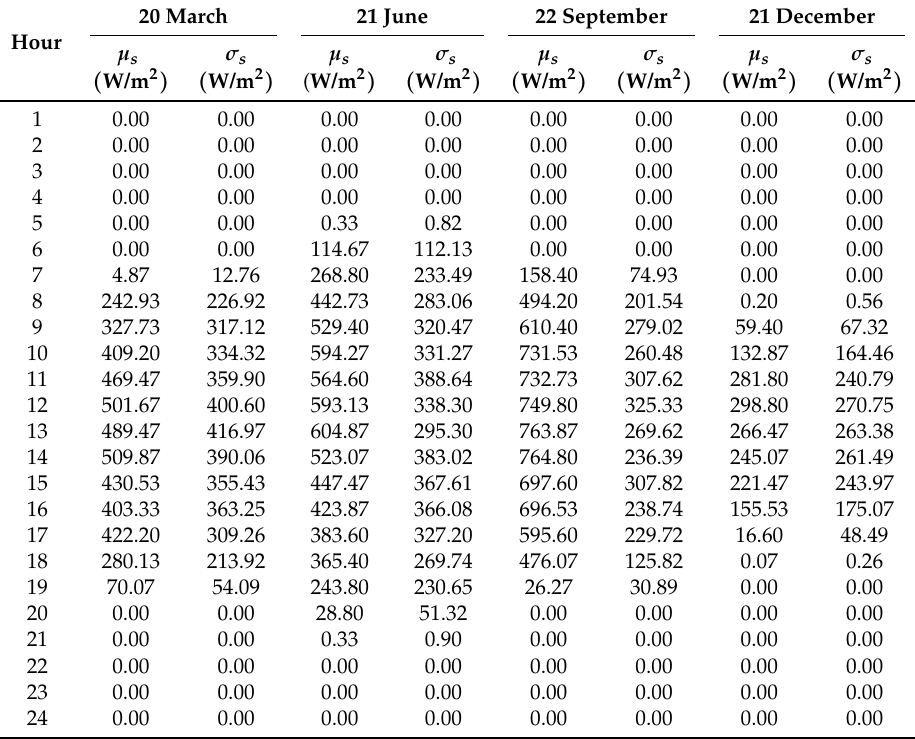
Table A6. Solar global horizontal irradiation parameters (mean and standard deviation) on four different